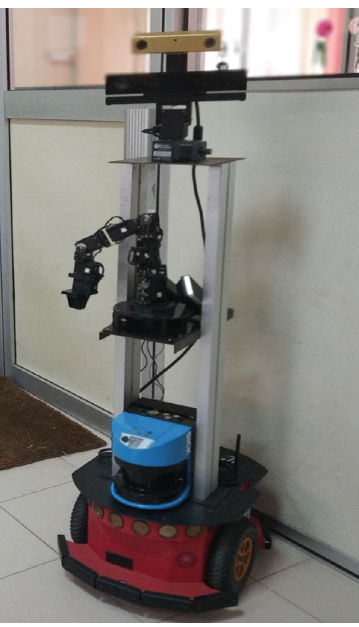
Figure 4: Service Robot platform used in the experiment: MIRob. Table 1: Some of the tasks selected for the study. Living area